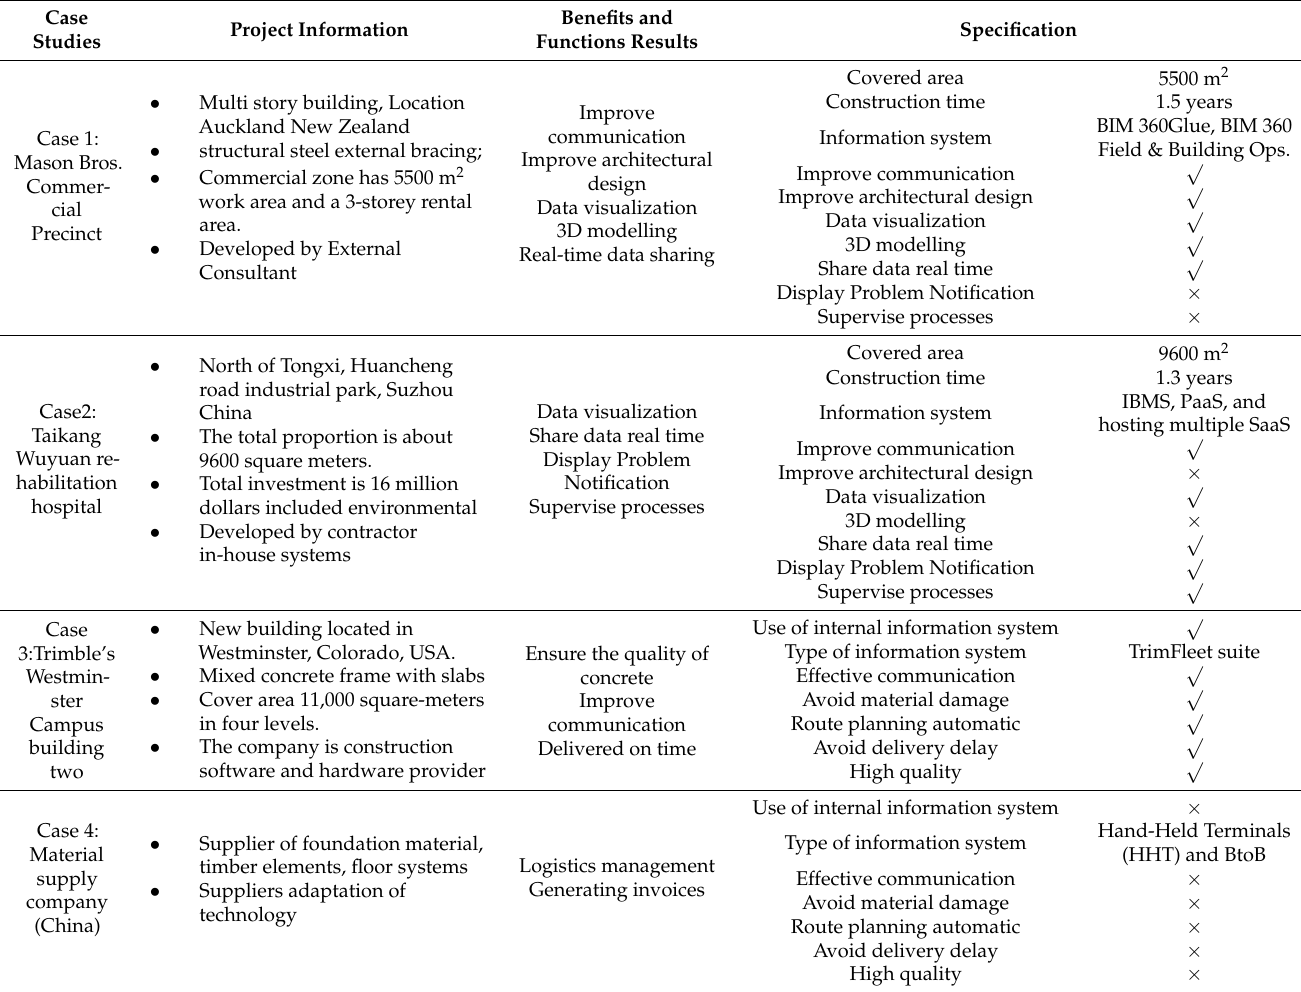
Table 2. Summary of the four case